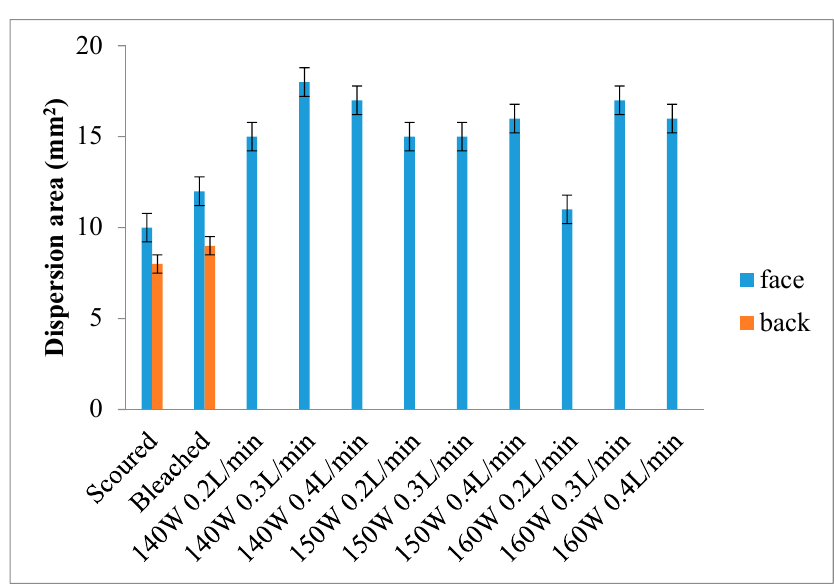
Figure 5. Dispersion size of single jersey fabric.